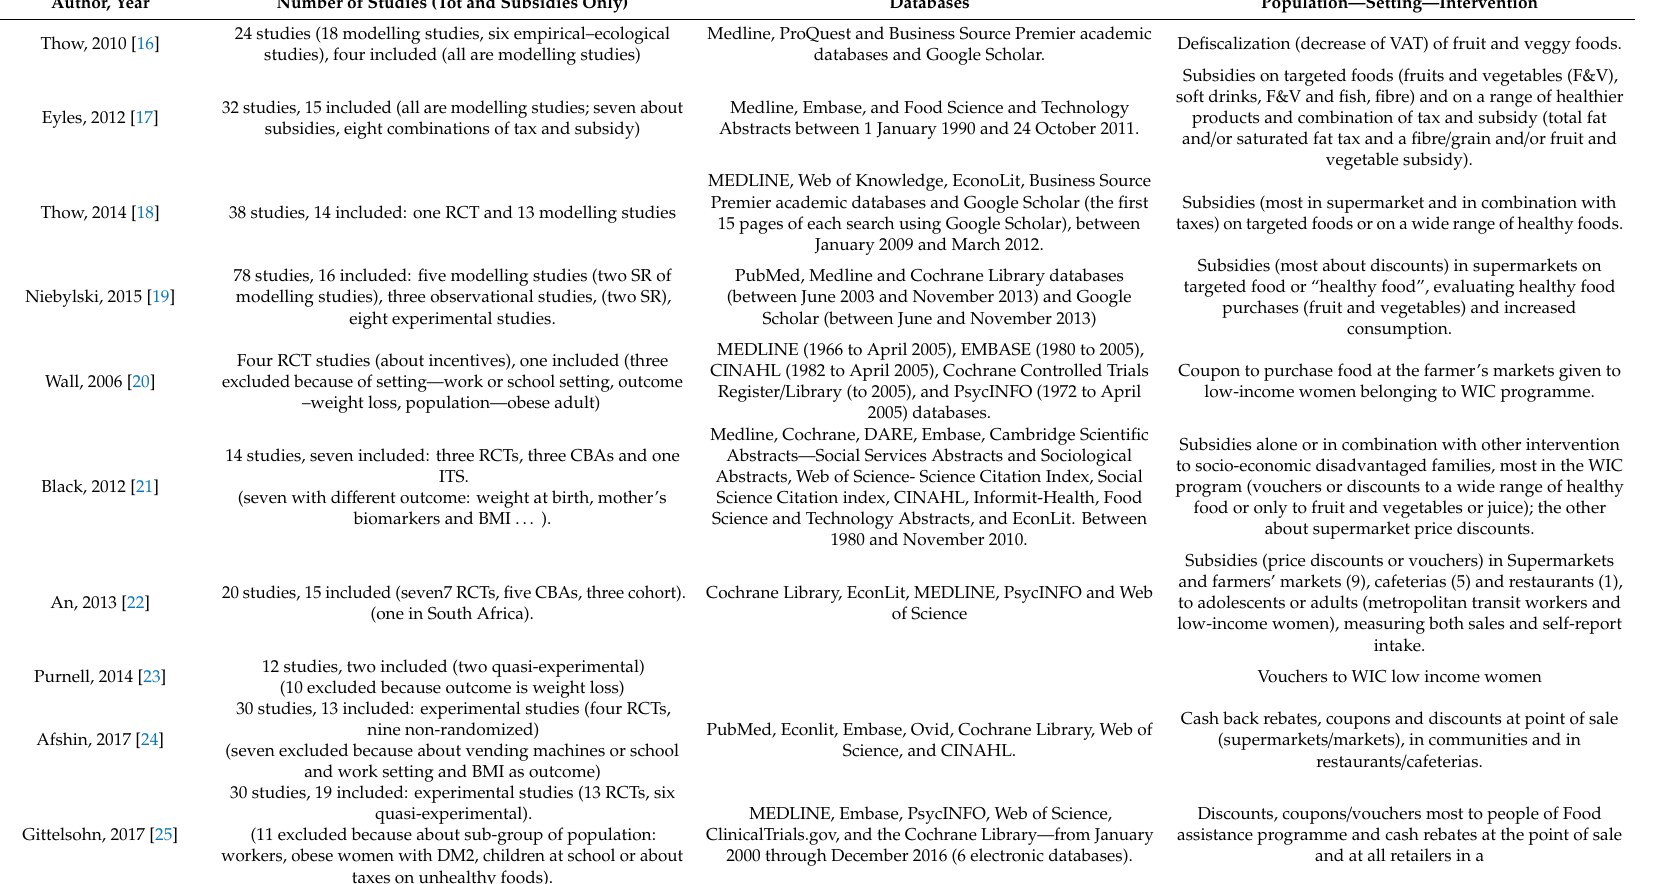
Table 3. Description of included review characteristics (RCT: randomized controlled trial; VAT: value added tax; CBA: controlled before-After; WIC: women, infants, and children; ITS: interrupted time series; SR: systematic review; BMI: body mass index; DM2: diabetes mellitus type